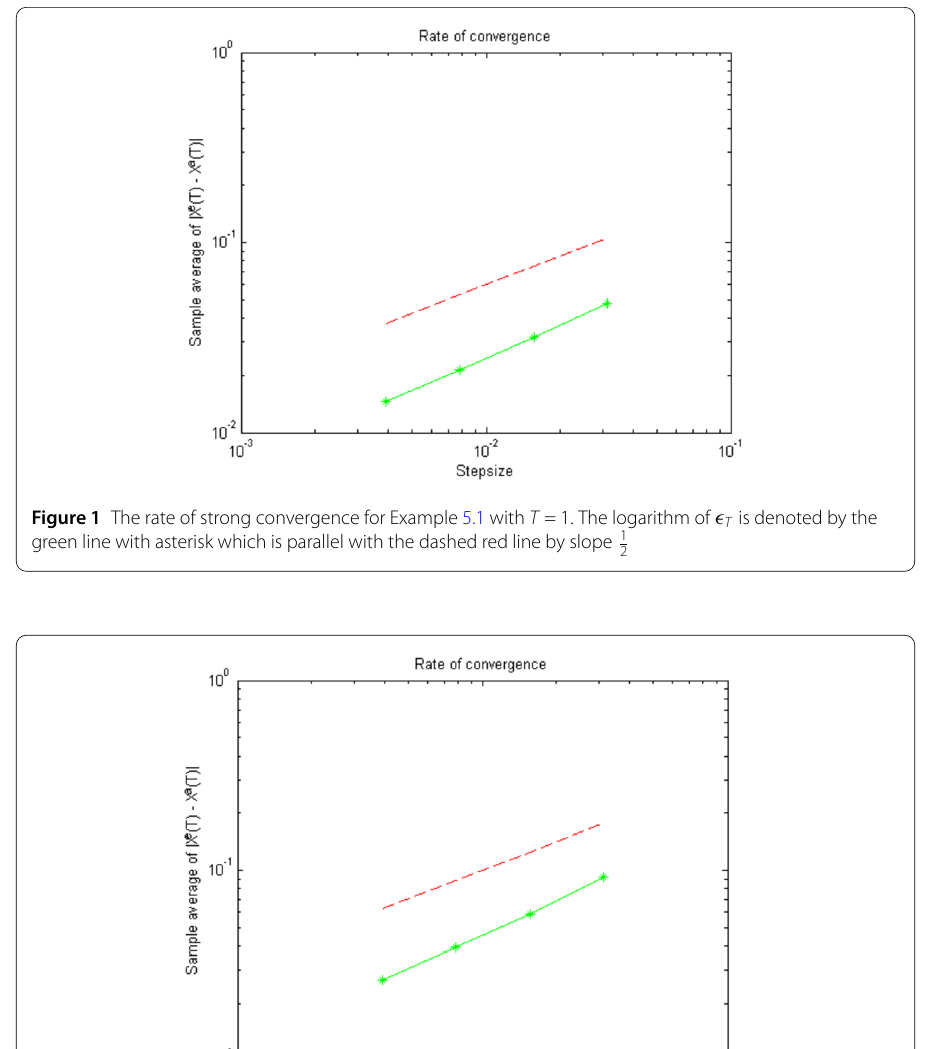
Figure 2 The rate of strong convergence for Example 5.2 with T = 1. The logarithm of (cid:14) T is denoted by the green line with asterisk which is parallel with the dashed red line by slope 1